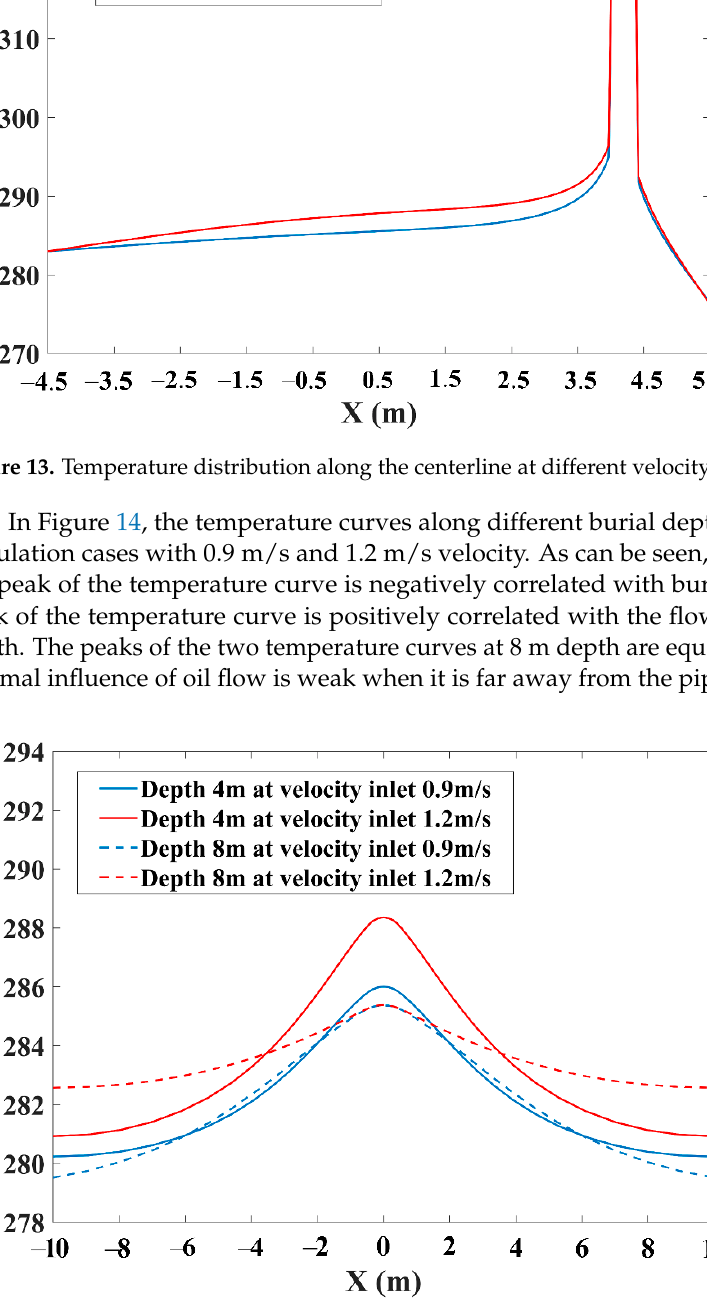
Figure 14. Temperature distribution at different depths in the case of 0.9 m/s and 1.2 m/s velocity.